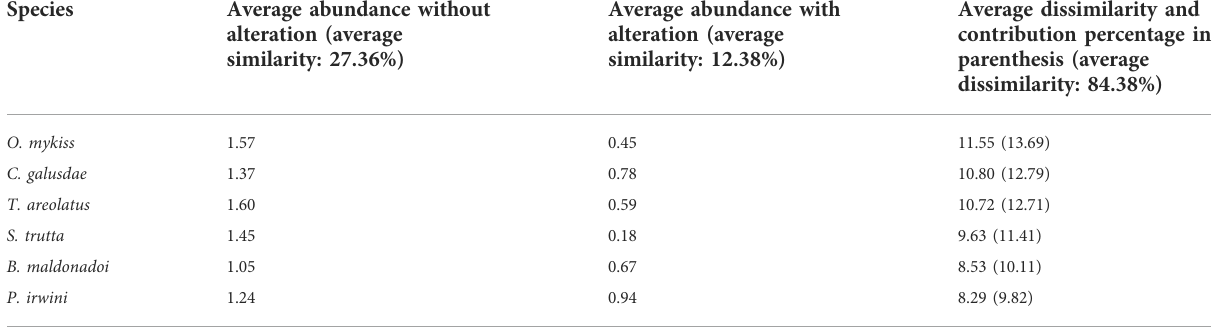
TABLE 4 Similarity percentage analysis (SIMPER) between time periods without direct channelization alteration (1986 – 2004) and with alteration (2012 – 2015) in the lower area of the Nonguén stream.